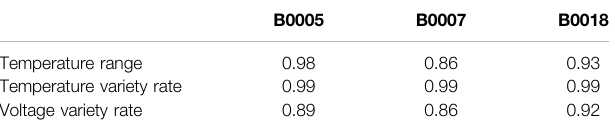
TABLE 1 | Correlation coef fi cients between different candidate indirect health factors and capacity.